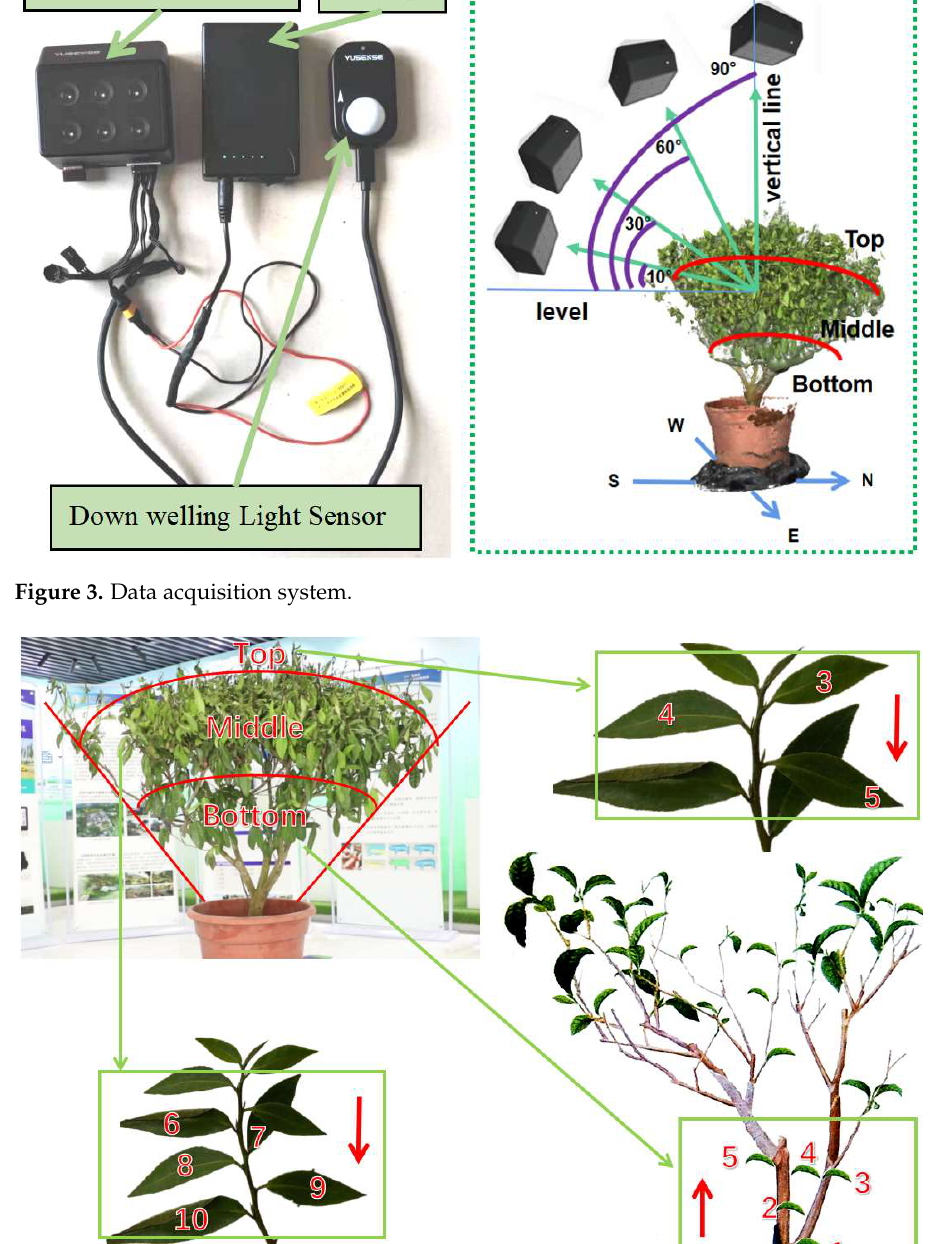
Figure 4. Schematic diagram of the sampling locations.